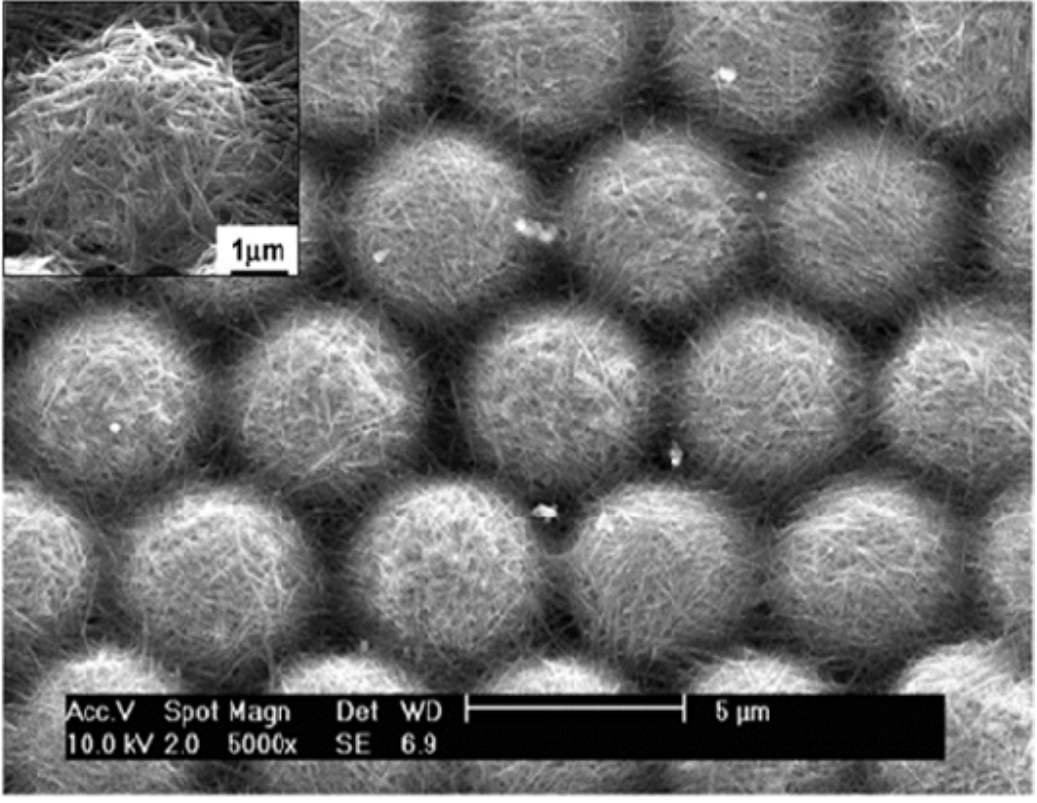
Figure 17. Surface morphology of the bionic surface prepared with PS microsphere/SWCNTs composition arrays, inset shows the higher magnification image of SWCNTs decorated microsphere. Images reprinted from [120], with permission from American Chemical Society, Copyright